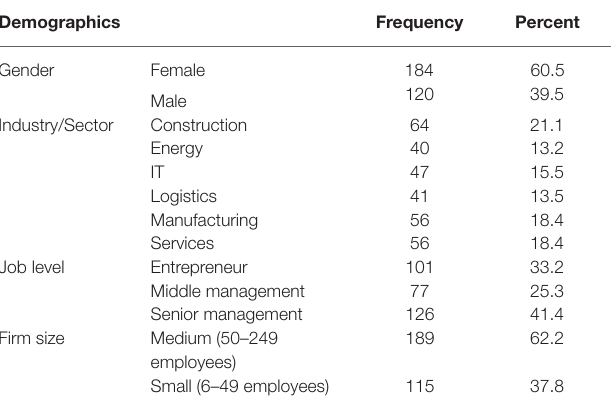
TABLE 1 | Demographic